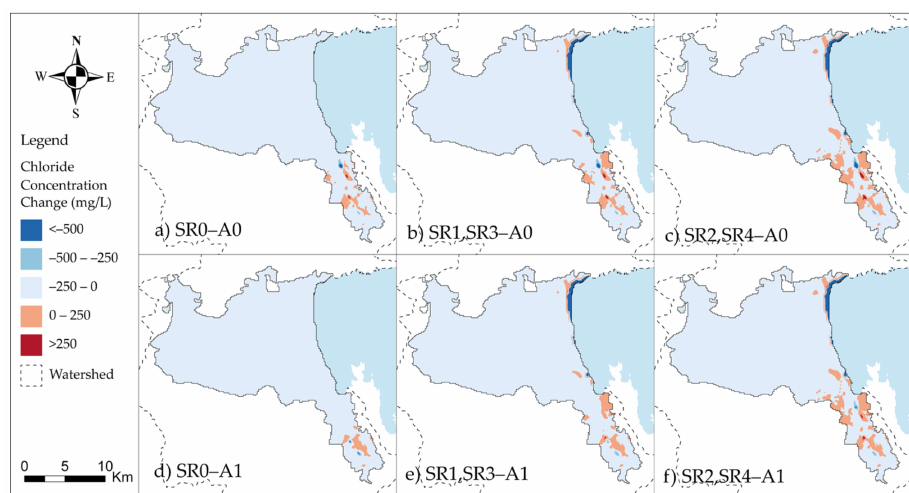
Figure 9. Chlorides Concentrations Change in (mg/L) of Almyros aquifer at the end of the simulation period (September 2018) between the baseline scenario (S0) and the various water resources and fertilization scenarios. ( a ) S0—(SR0-A0), ( b ) S0—(SR1, SR3-A0), ( c ) S0—(SR2, SR4-A0), ( d ) S0—(SR0- A1), ( e ) S0—(SR1, SR3-A1), and ( f ) S0—(SR2,